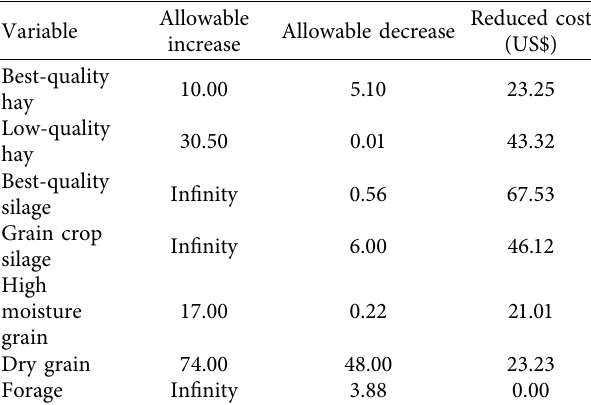
Table 3: Summary of costs.